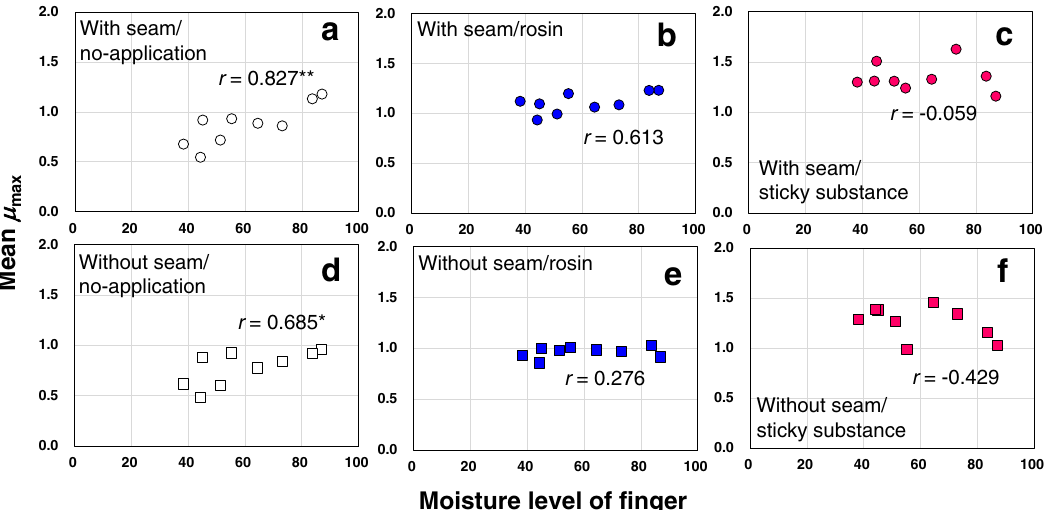
Fig. 4 Relation between the moisture level of the fi nger and friction coef fi cient. a No application with seam. b Rosin application with seam. c Sticky substance application with seam. d No application without seam. e Rosin application without seam. f Sticky substance application without seam. * p < 0.05, ** p < 0.01.